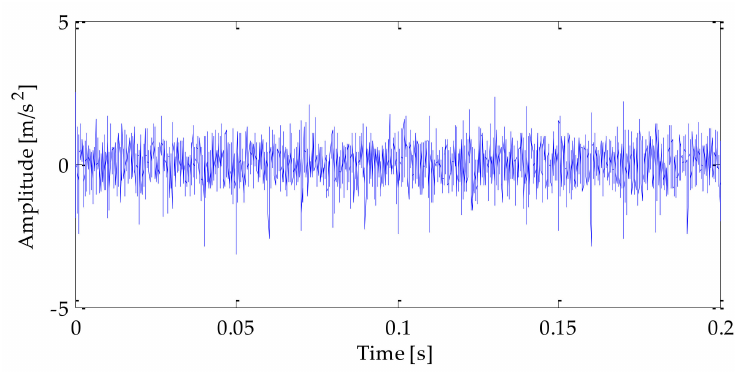
Figure 13. LMD–RobustICA noise-reduction results.